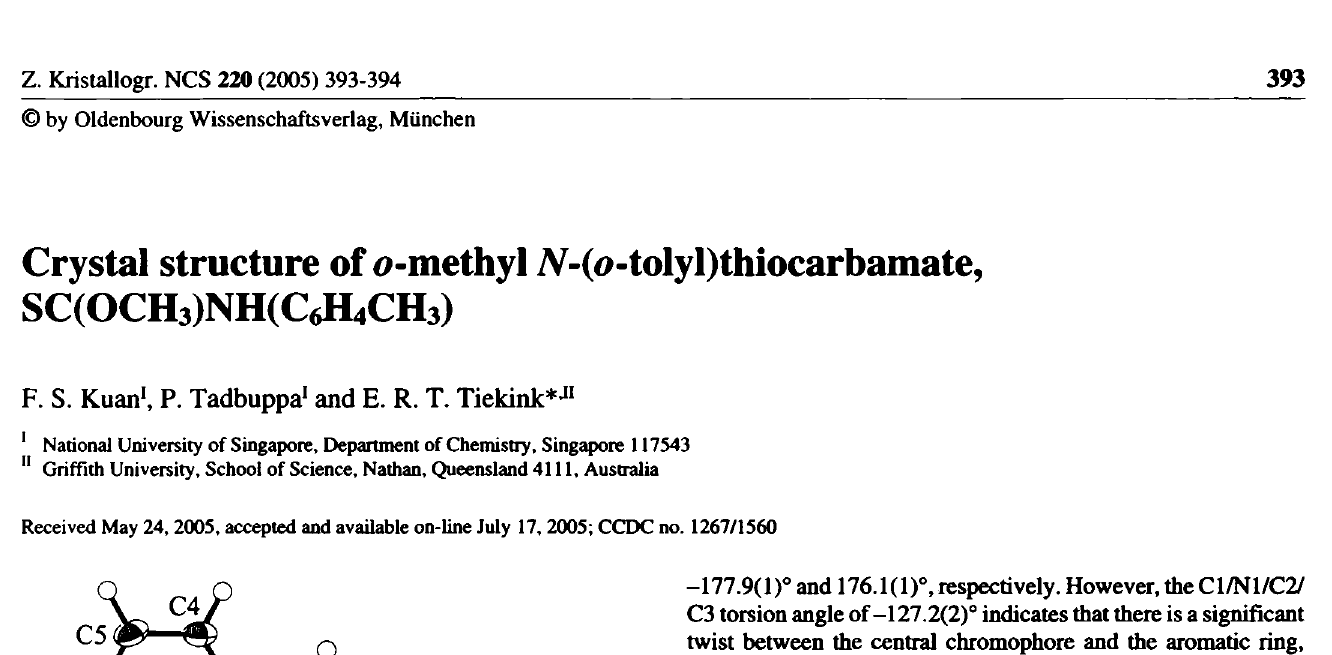
Table 1. Data collection and handling.